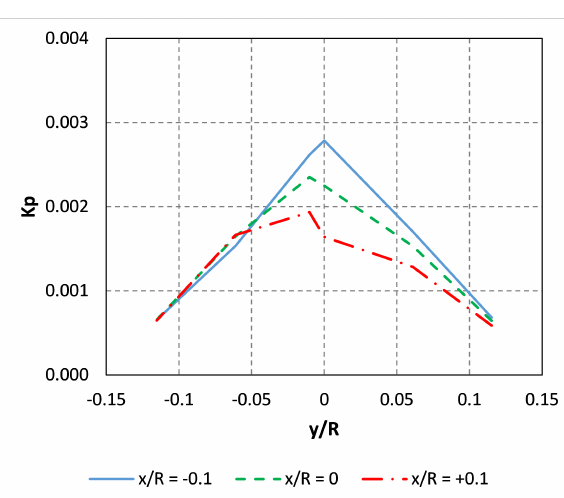
Figure A.4: Second harmonic values in correspondence to different points on the hull stern. Influence of the longitudinal position with the full-scale Nominal inflow